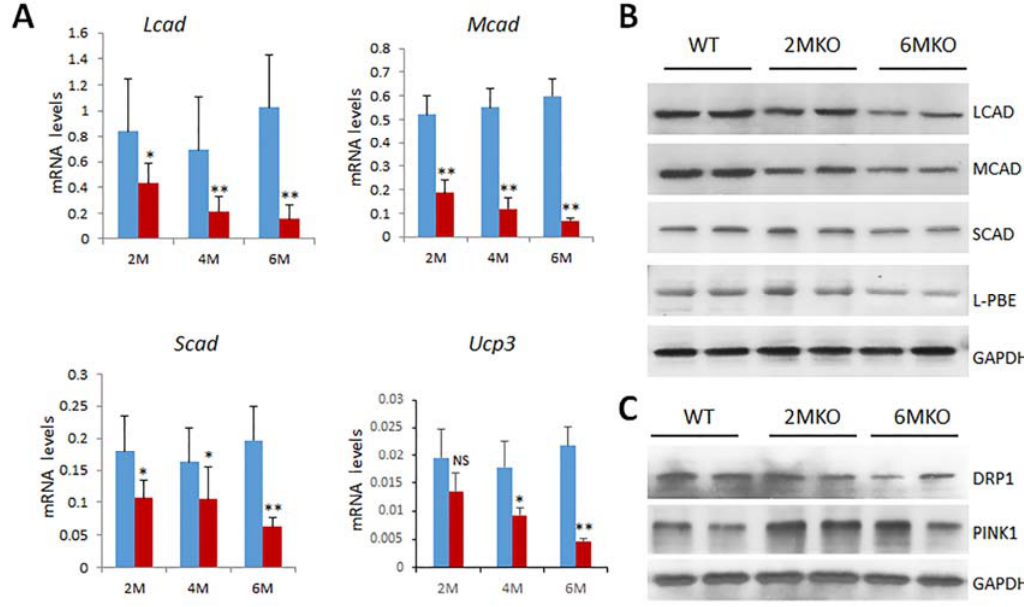
Figure 4. Expression of fatty acid metabolism genes is decreased in csPIMT − / − hearts. ( A ) Quantification of mRNA levels of Lcad (Long chain acly ‐ CoA dehydrogenase), Mcad ( medium ‐ chain acyl ‐ CoA dehydrogenase), Scad ( short ‐ chain acyl ‐ CoA dehydrogenase) and Ucp3 ( uncoupling protein 3) genes. * p < 0.05, ** p < 0.01, NS: not significant; ( B ) Western blot showing protein levels of LCAD (47 Kda), MCAD (46 Kda), SCAD (44 Kda) and L ‐ PBE (78 Kda; Enoyl ‐ CoA hydratase / L ‐ 3 ‐ hydroxyacyl ‐ CoA dehydrogenase). Percent reduction (KO vs. WT) for LCAD, 40%; MCAD, 39%; SCAD, 45%, and L ‐ PBE, 27% for 6 ‐ month time point. Each group was analyzed using 5 different mice and the values were expressed as the mean ± SD; ( C ) Western blot showing the protein levels of DRP1 (78 Kda) and PINK1 (60 Kda). Details of same as in ( A ). See Materials and Methods for antibody sources and dilutions.